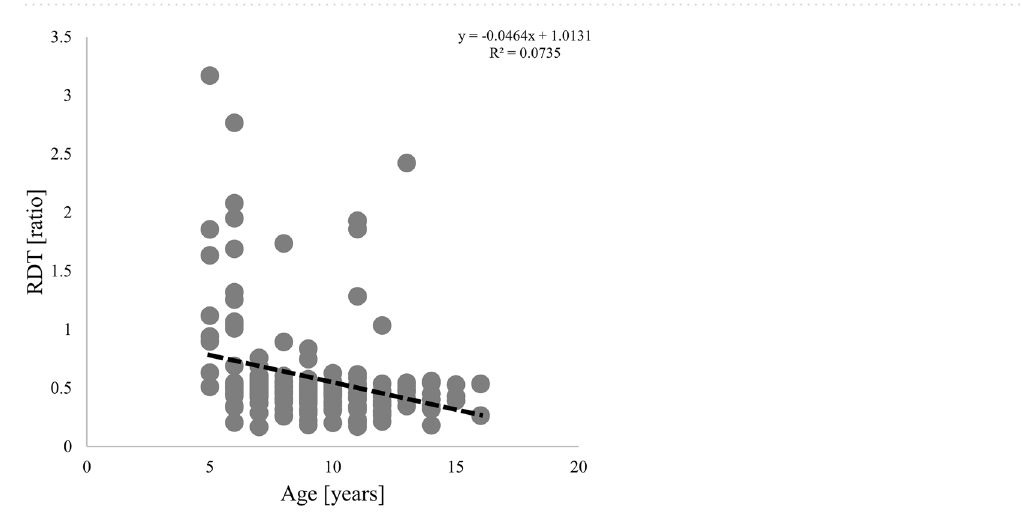
Figure 3. Detection probability curves of action-outcome regularity in each manual dexterity group and their comparison. ( A ) The colored curves show the detection probability curves of action-outcome regularity for each manual dexterity group. The black dashed line represents the action-outcome regularity detection threshold (66.6%). ( B ) Comparative results of the regularity detection threshold (RDT) for each manual dexterity group. Lines represent the range of the minimum and maximum. Boxes represent the lower, median, and upper quartiles. * p < 0.05, ** p < 0.01.